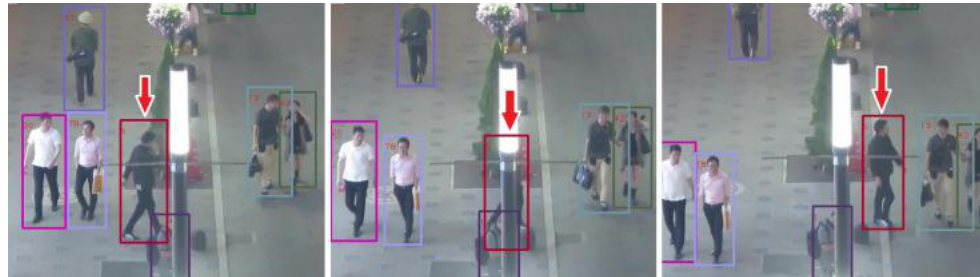
Figure 3. Occlusion tolerance of ViTT. As shown by the arrow, when a person passes through the shelter, ViTT can still track them accurately. The identifiable image in this figure is from the public dataset MOT16.